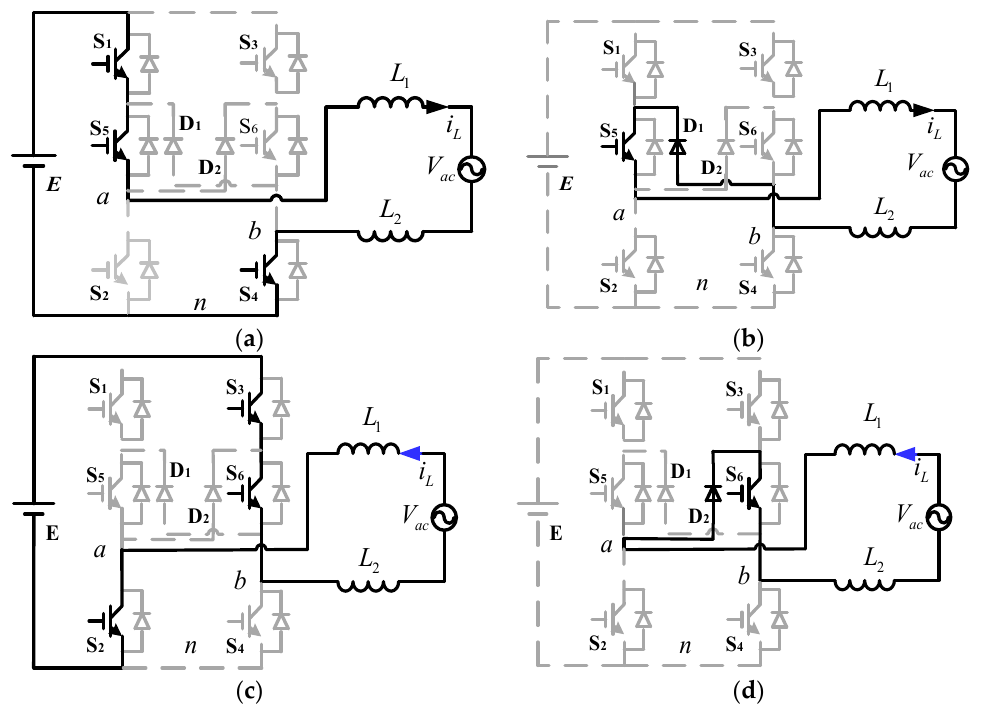
Figure 2. Switching states for modulation mode I. ( a ) Switch state 1, i L > 0, S1 S4 S5 on, ( b ) switch state 2, i L > 0, S1 S4 off, S5 on, ( c ) switch state 3, i L < 0, S2 S3 S6 on, ( d ) switch state 4, i L < 0, S2 S3 off, S6 on.